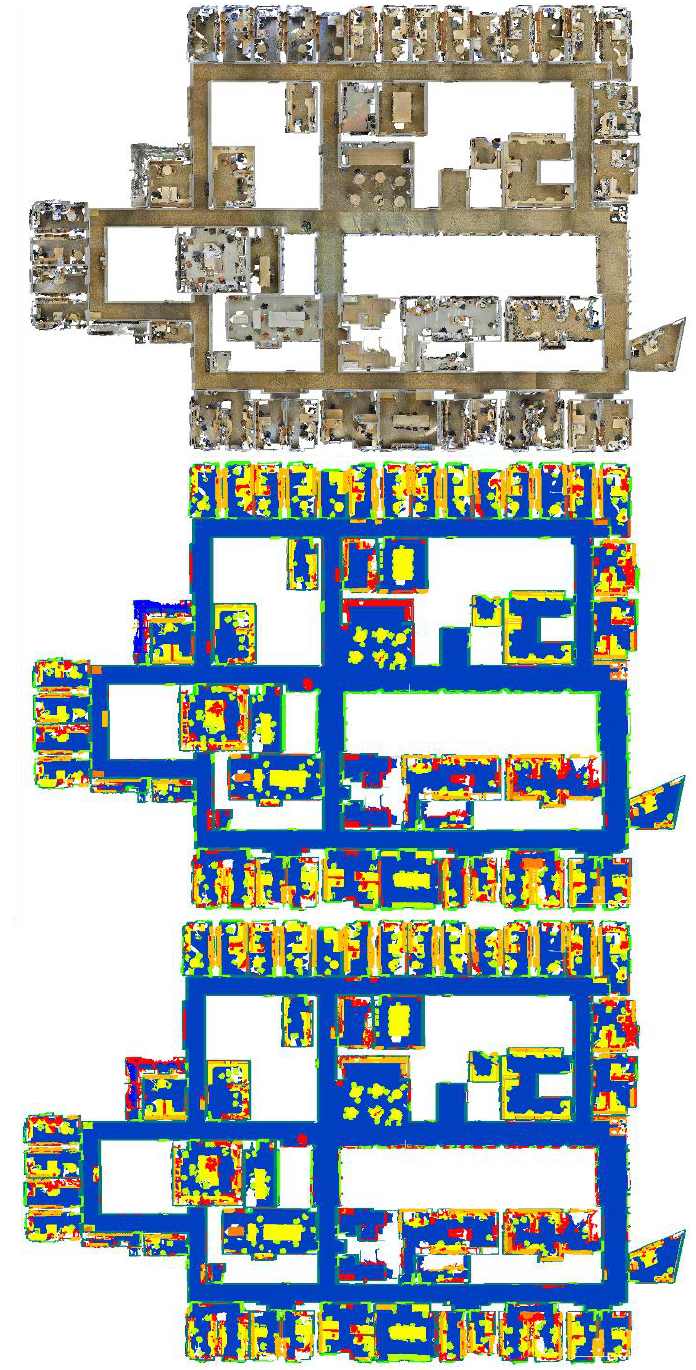
Figure 10. The semantic segmentation results of Area 5: The top panel shows the raw RGB data. The middle panel is the ground truth. The bottom panel shows the predictions.